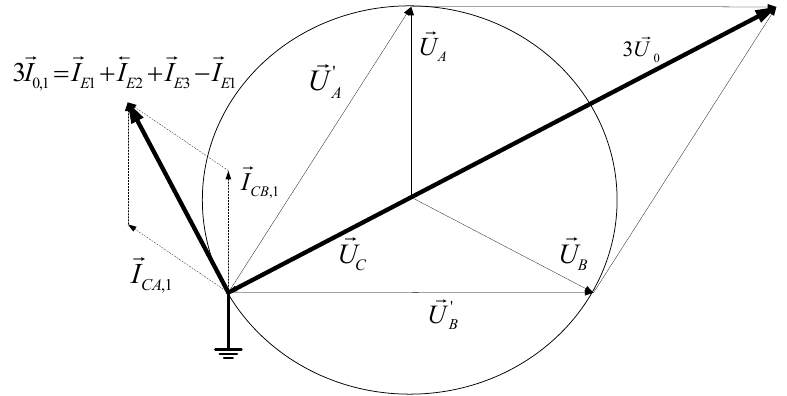
Figure 3. Current transformers connected in Holmgreen connection.